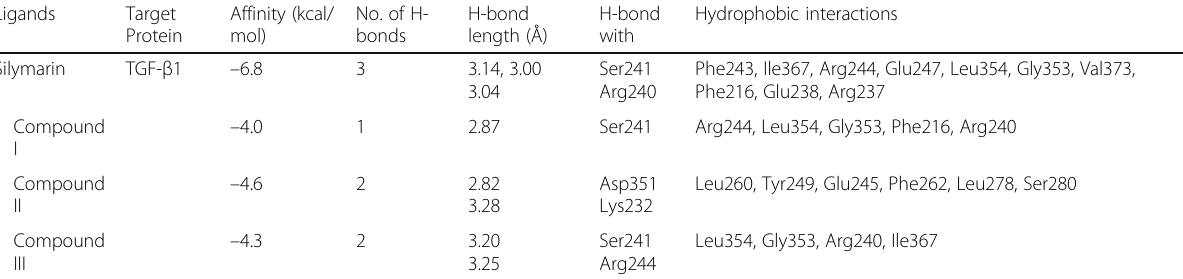
Table 5 Binding energy, No. of H- Bonds, H- Bond length, H-bond with and hydrophobic interactions of TGF- β 1 ligands with receptors Ligands Target Affinity (kcal/ Protein mol)